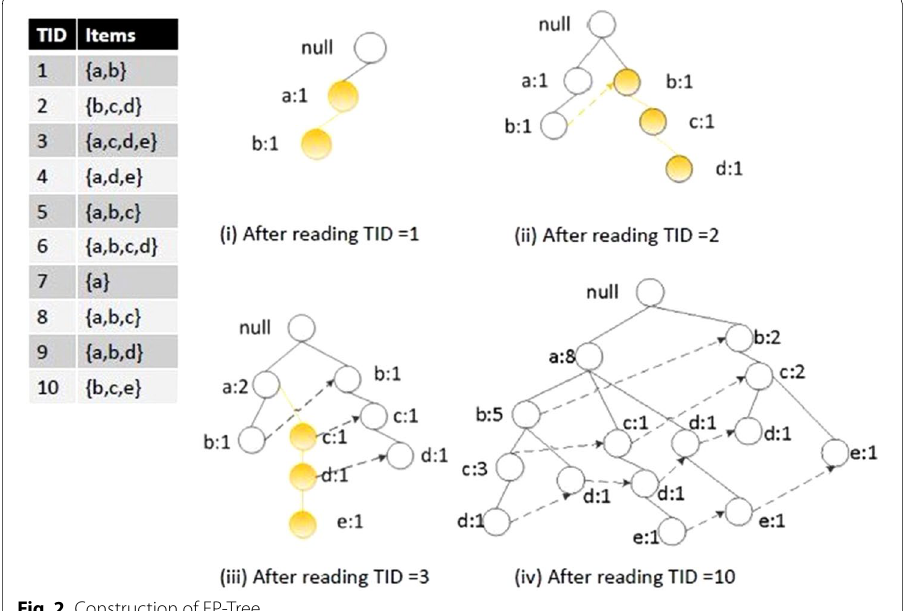
Fig. 2 Construction of